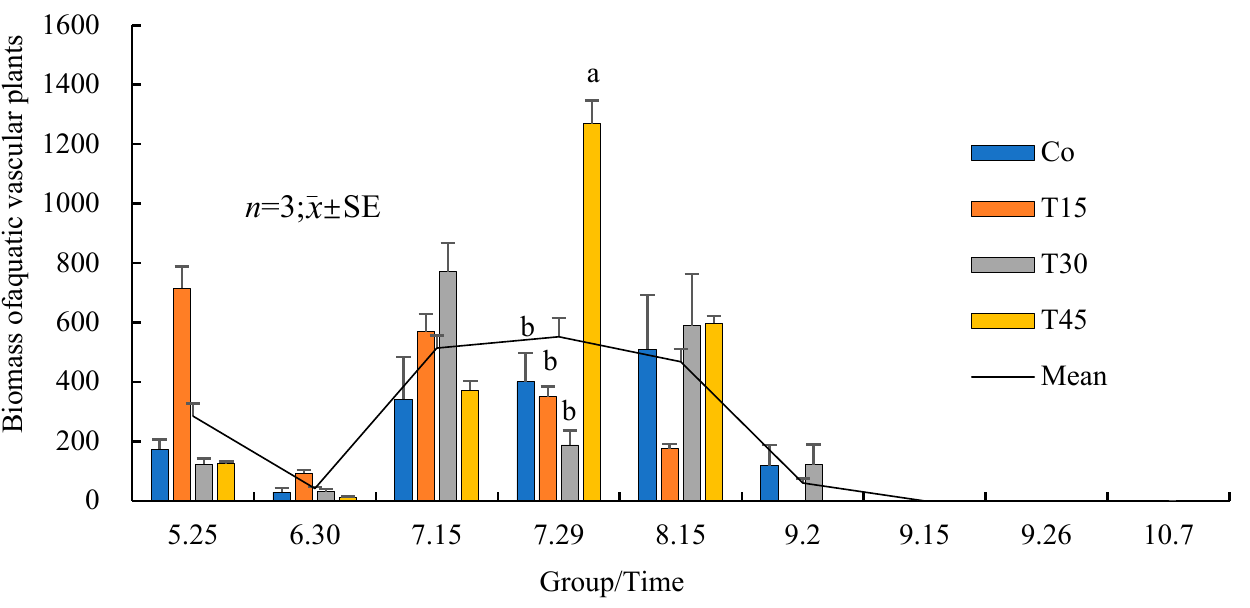
Figure 14. Biomass of the submerged plants in different treatment groups during the experiment.